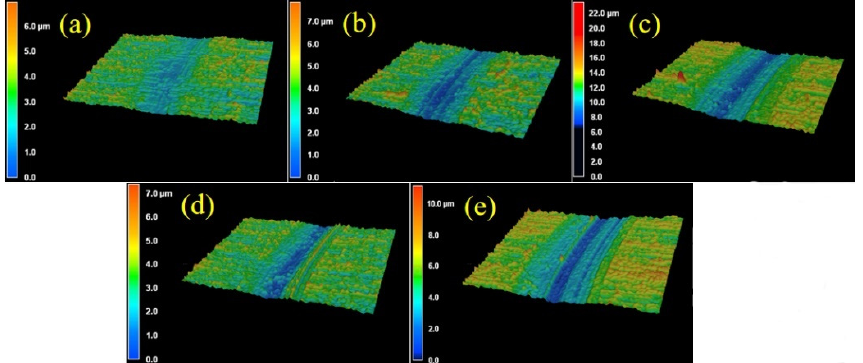
Figure 7. Three-dimensional laser confocal images of the wear tracks of MQPT specimen under different wear loads and wear times. ( a ) 5N, 5h; ( b ) 10N, 5h; ( c ) 20N, 5h; ( d ) 20N, 1h; ( e ) 20N, 3h.